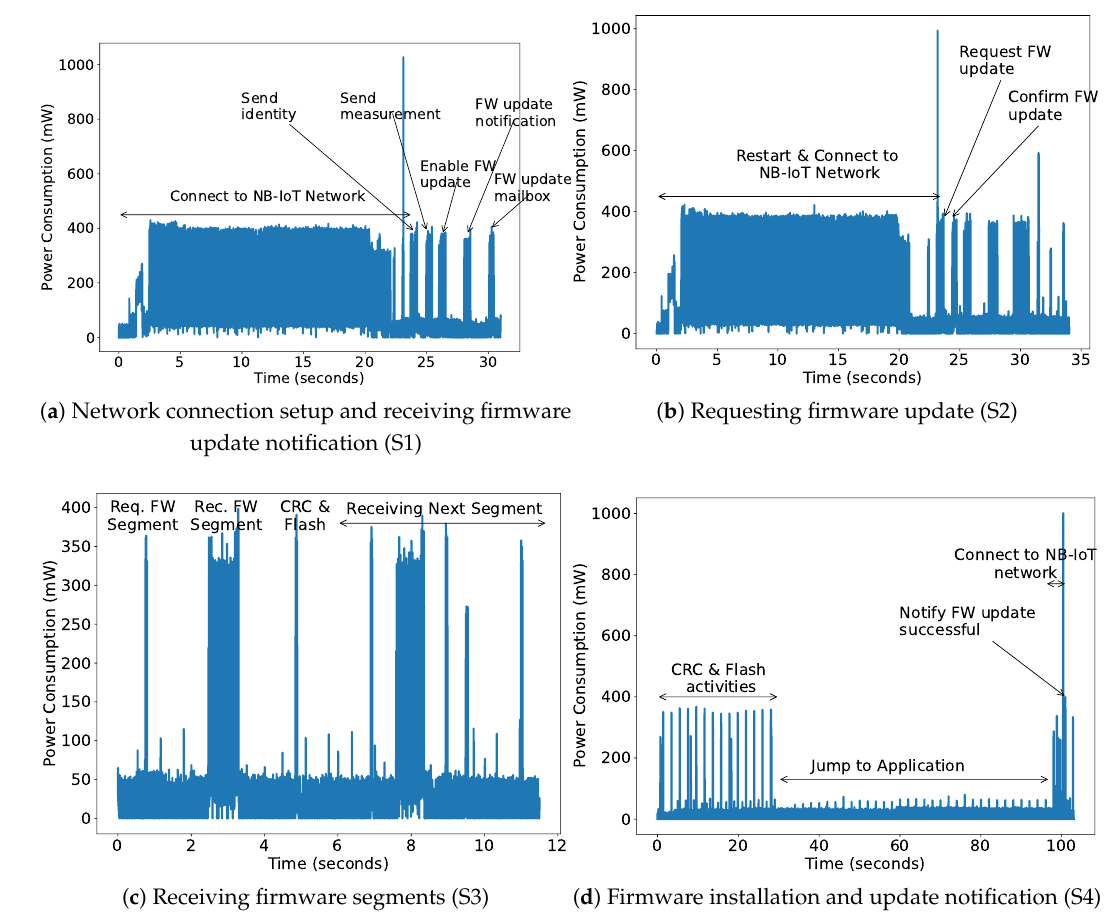
Figure 11. Power consumption of Firmware Update